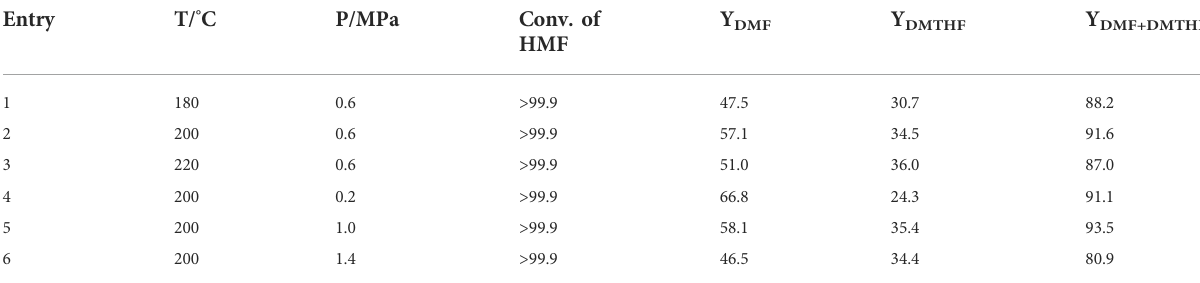
TABLE 4 The effects of temperature and pressure on the conversion of HMF over Cu/SiO 2 -HT-8.5 catalyst.